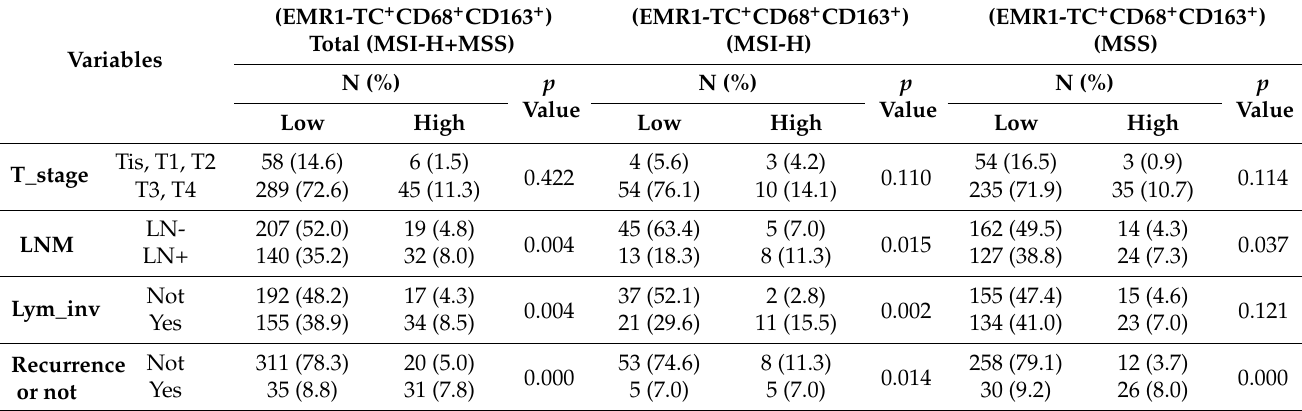
Figure 2. EMR1, cluster of differentiation (CD)68, and CD163 expression in primary tumor of colorectal cancer (CRC). ( A–D ) Colon cancer tissues stained with hematoxylin and eosin (H & E), ( E–H ) EMR1, ( I–L ) CD68, and ( M–P ) CD163 immunohistochemistry (IHC) staining in primary tumor of CRC. CD68 + CD163 + TAMs were higher in high EMR1-TC expression area com- pared to low expression area ( E–P ). Total number of samples, n = 399. Total number of samples used for representative images, n = 2. Original magnification, 10 × and 40 × . Table 3. Correlation between combined EMR1-TC + CD68 + CD163 + expression and clinicopathologic parameters in MSI-H and MSS